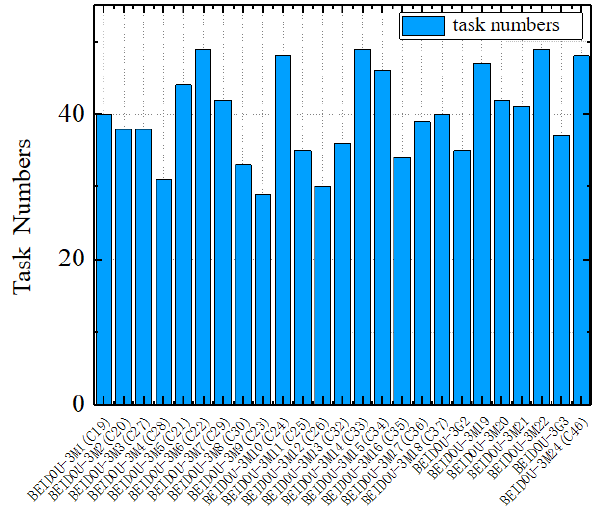
Figure 12. The simulation results. Set DCCF-GA on the simulation platform, and then get the final collaborative result. Table 3. The simulation results, completion time and energy consumption of the BEIDOU-3